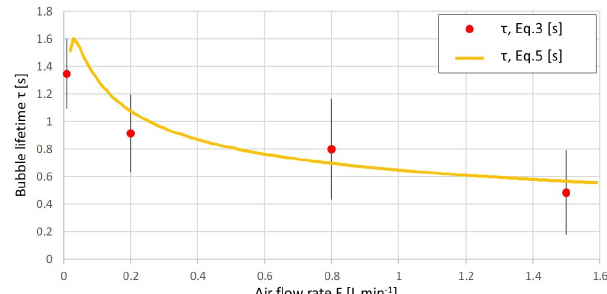
Figure 10. Bubble lifetime, derived from the observed foam area and mean bubble size with Eq. (3); the approximation of Eq. (4) assumes the foam thickness of